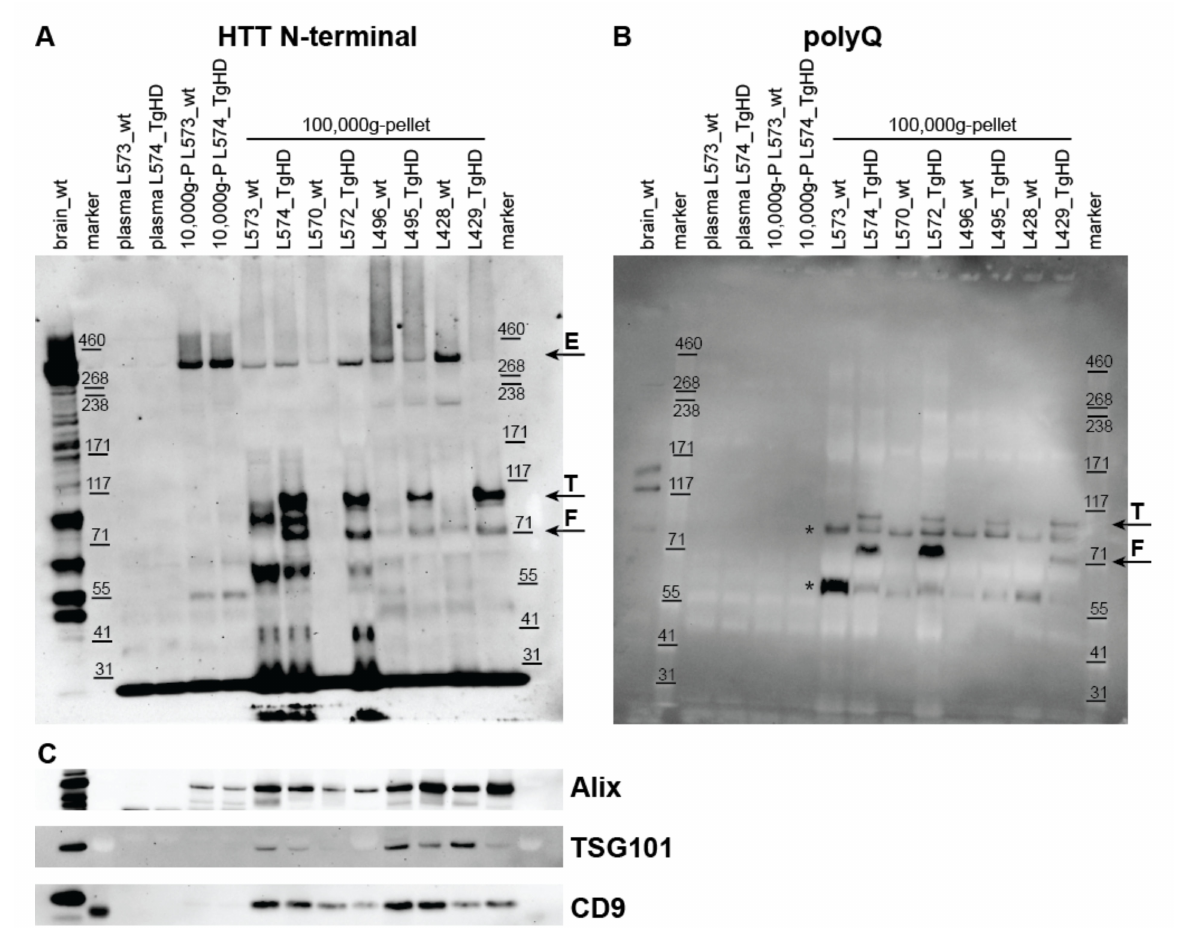
Figure 3. Huntingtin and exosome marker detection in 100,000 × g centrifugation pellets containing extracellular vesicles, isolated from blood plasma of the transgenic Huntington ´ s disease pig model. ( A ) anti-N-terminal HTT antibody (EPR5526) was used to detect total HTT levels in plasma, 10,000 × g pellets and 100,000 × g pellets. Wild-type pig brain homogenate was used as positive control. Endoge- nous full length ~360 kDa HTT was detectable in 10,000 × g and 100,000 × g pellets from plasma of both wild type (wt) and transgenic (TgHD) pigs (arrow E). In addition, the ~110 kDa human HTT transgene (arrow T) and a ~70 kDa fragment (arrow F) were detectable in TgHD pig 100,000 × g pellets. ( B ) A polyQ-specific antibody (MW1) provided the same ~110 and ~70 kDa band pattern in TgHD pig 100,000 × g pellets as EPR5526, thus confirming the presence of mutant HTT (arrows). Additional polyQ-containing protein bands were detected in 100,000 × g pellets (asterisks). ( C ) Expression of exosome markers Alix, TSG101 and CD9 were abundant in 100,000 × g pellets containing extracellular vesicles, in contrast to 10,000 × g pellets and original plasma (sample IDs are identical as in panel ( A